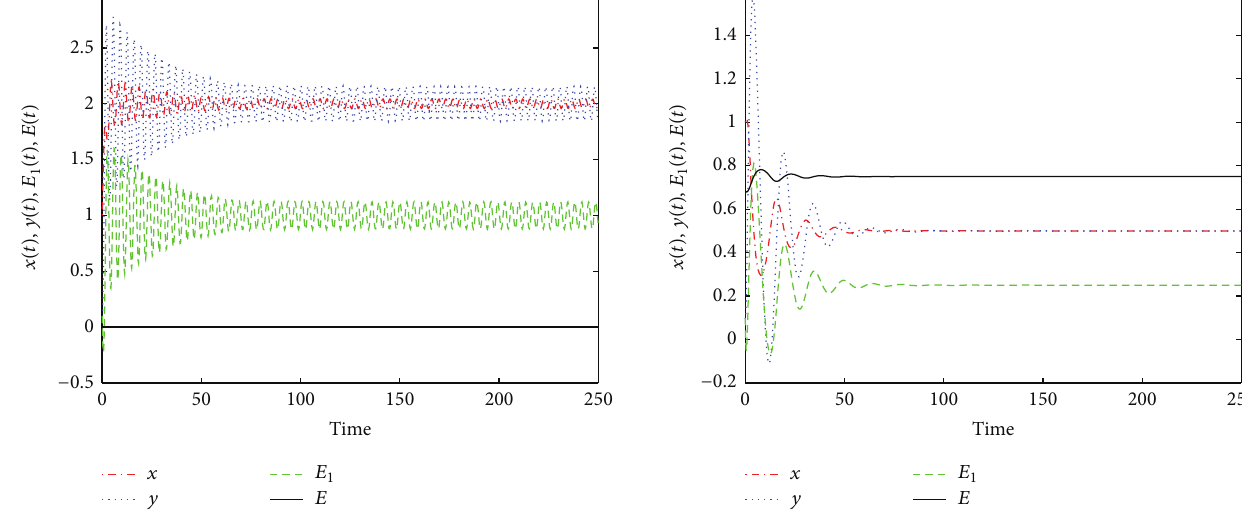
Figure 2: The dynamic responses of (45) near equilibrium ( 𝑘 1 = 4 , = −1.75 𝑘 2